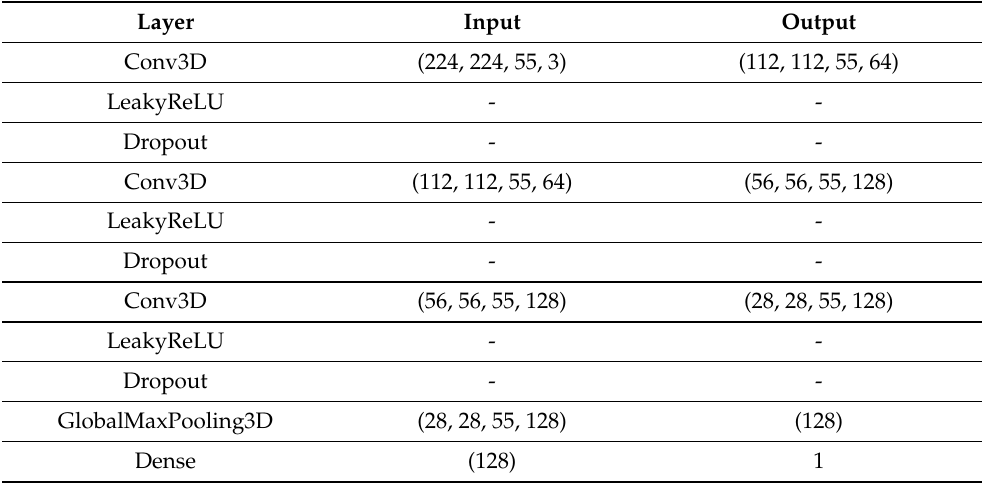
Figure 4. Two illustrative examples of anomalous frames obtained by the proposed generator using Gaussian noise applied to the normal frame in ( a ). The noise severity is higher at the beginning of the discriminator learning process, as shown in ( c ). It becomes smoother and more realistic as the discriminator loss decreases, as observed in ( b ). Table 1. Architecture of the customized discriminator component of the 3D-GAN designed to detect anomalies in video